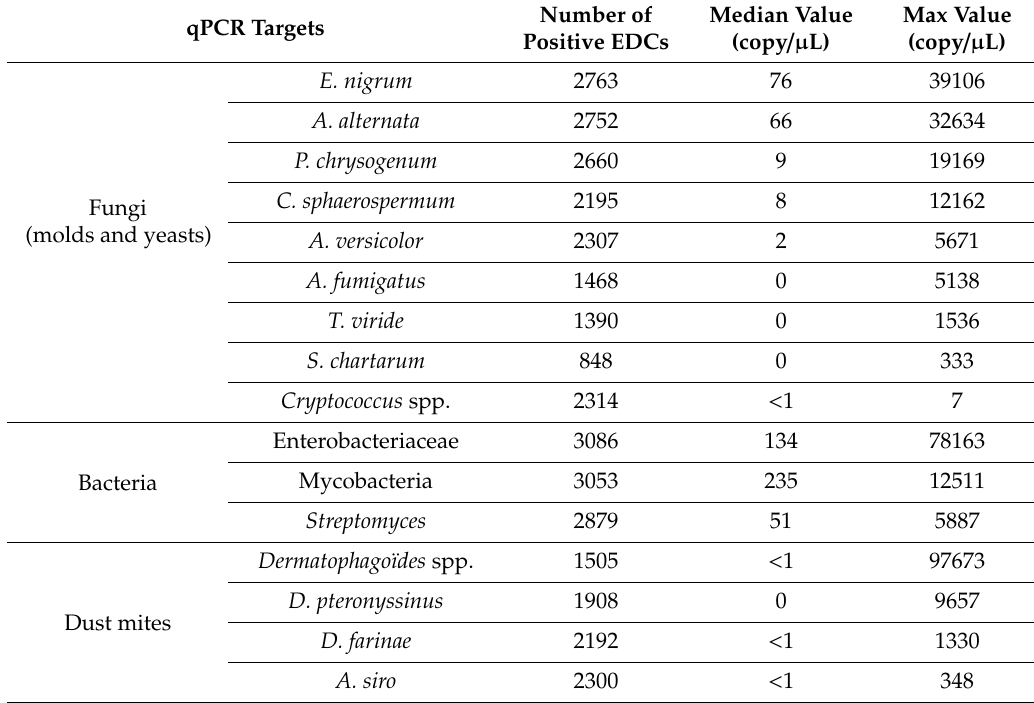
Table 2. Positivity and quantification of each target by qPCR in the 3143 electrostatic dust collectors (EDC)